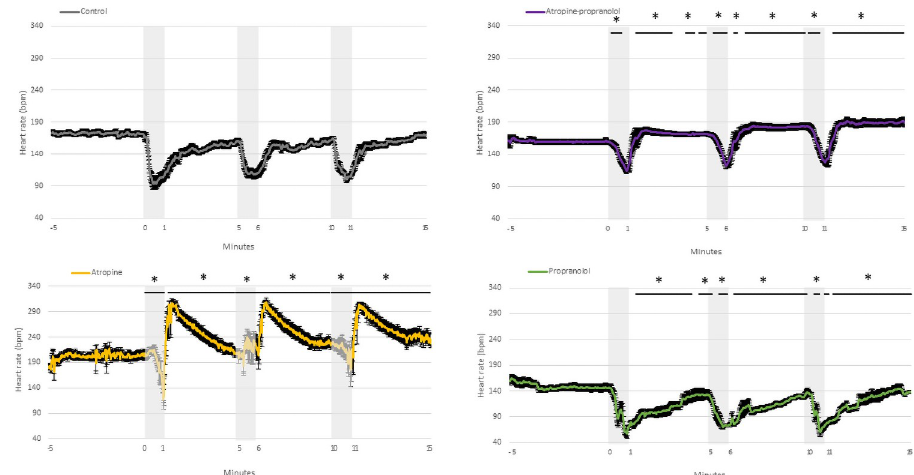
Fig 2. Fetal heart rate. Fetal heart rate in control, atropine, propranolol and atropine-propranolol protocols in fetuses exposed to three applications of 1-minute umbilical cord occlusion (grey zone) every 5 minutes. Data are expressed as mean ± standard error. � p < 0.05 vs. control. Resolution of each datapoint: 1 second.